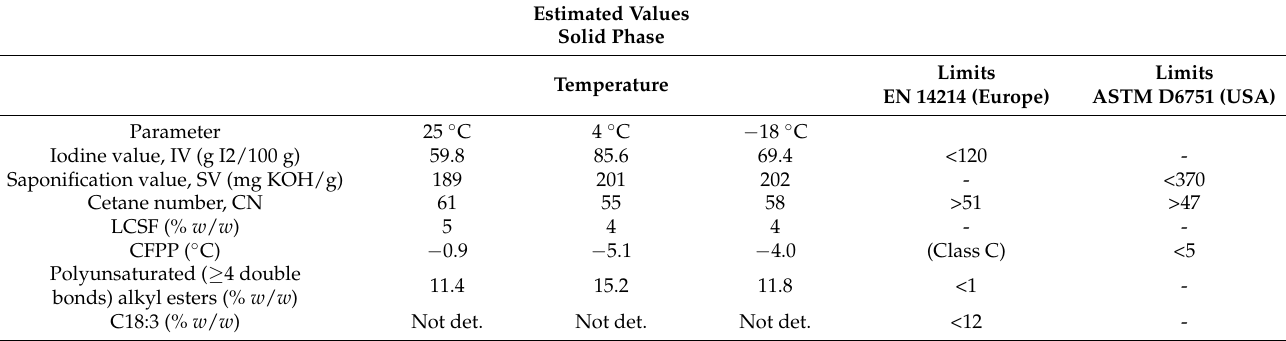
Table 3. Theoretical estimate of FAEE